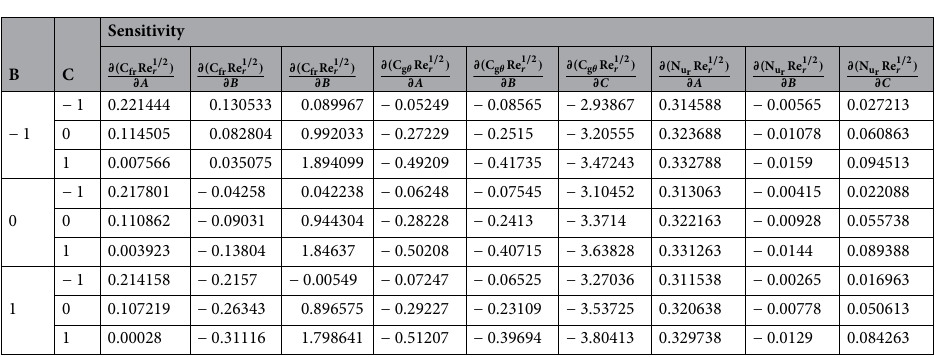
Table 8. Sensitivity analysis with A = 0 and all combination of magnetic parameter and suction parameter for 1 / 2 skin friction coefficients C fr Re